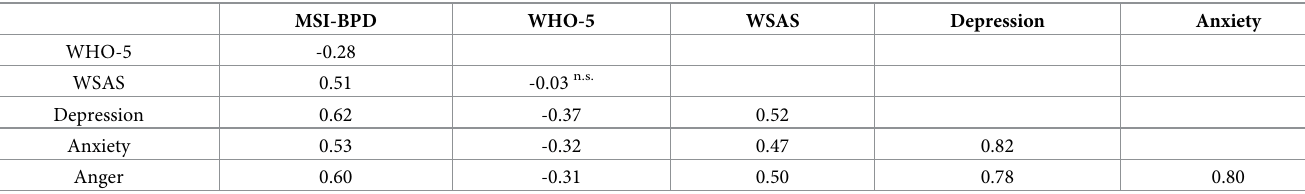
Table 1. Correlations of borderline symptoms, functioning, and internalizing disorder symptoms (n =